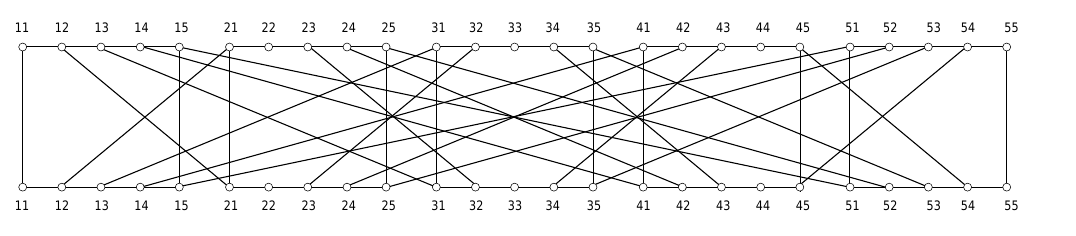
Figure 4: Biswapped network Bsw ( P 5 )